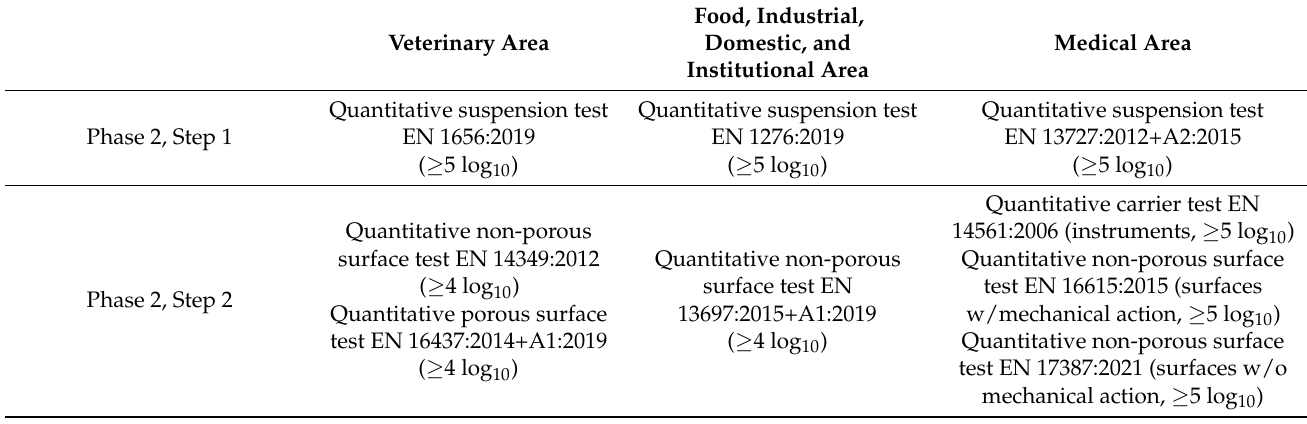
Table 1. Standardized protocols for the evaluation of disinfectant efficacy within the medical, veteri- nary, and industrial sectors. Given are the EN standards, test substances (suspension, carrier, surface), and minimal CFU reduction values necessary for successful disinfection